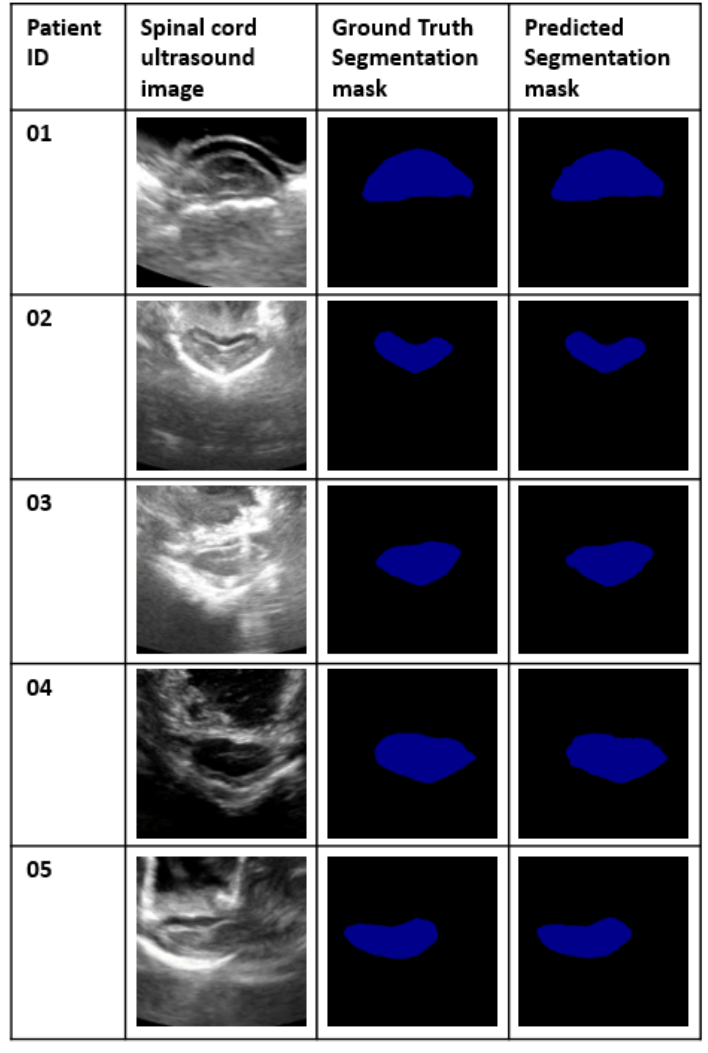
Figure 13. Samples from Dataset-A (patient 01 to patient 05), the ground truth and the predicted segmentation